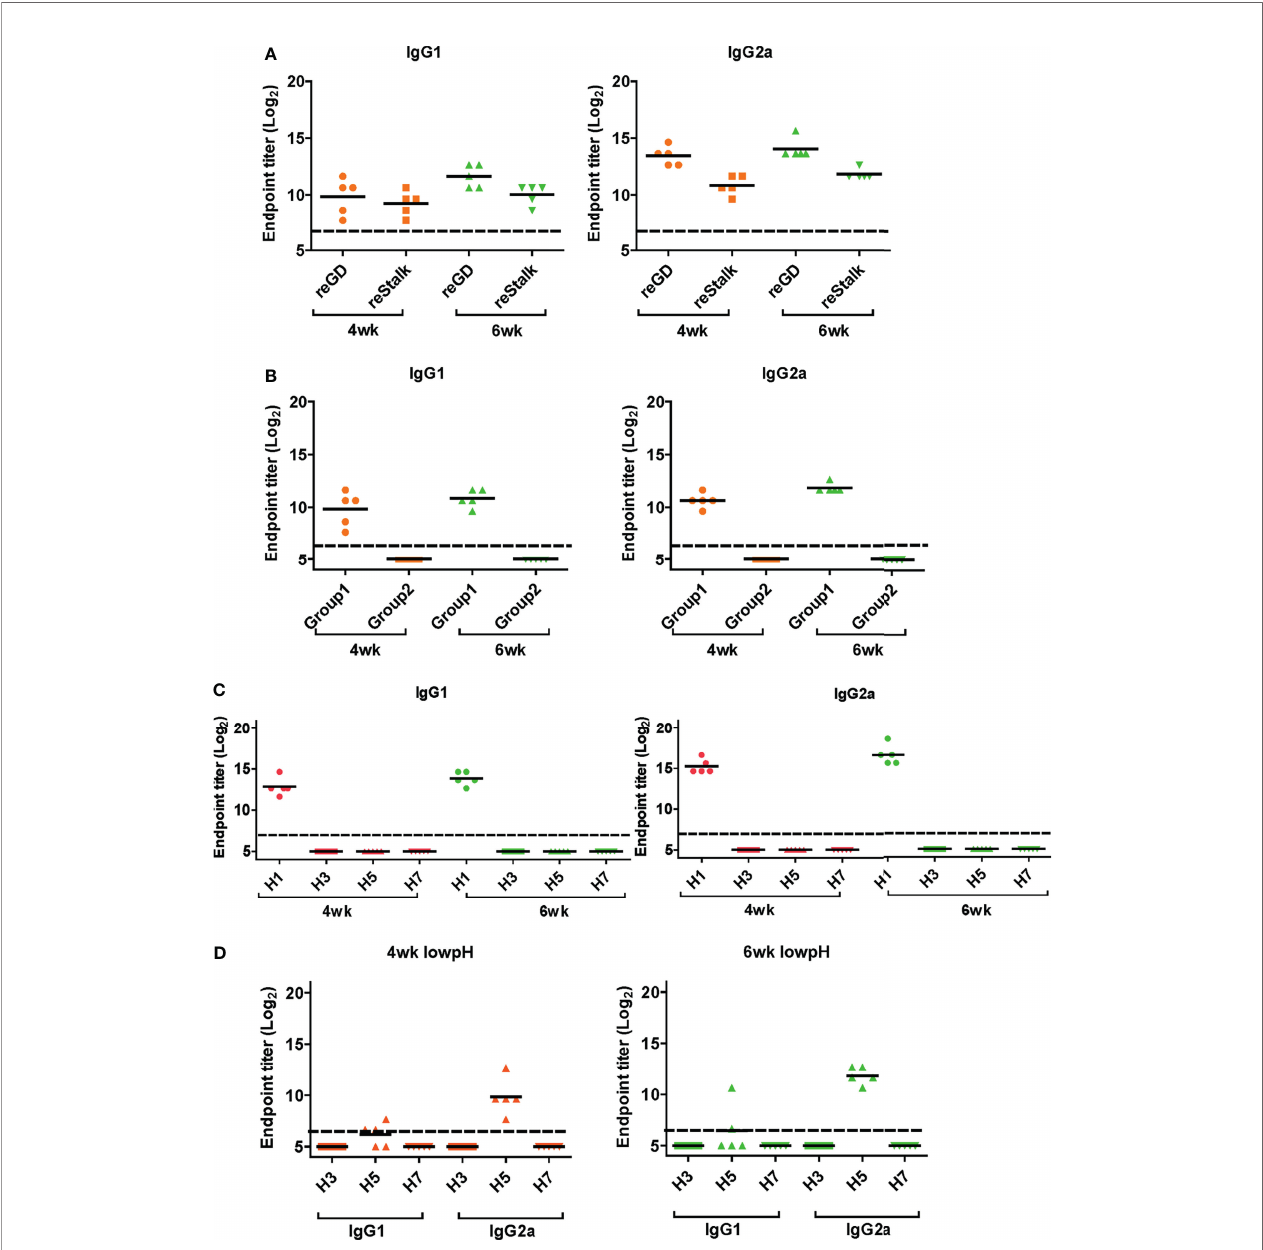
FIGURE 5 | Response of cross-protective antibodies to hemagglutinin (HA) proteins. (A – D) In fl uenza HA protein-speci fi c IgG1 and IgG2a were detected by ELISA analysis. Two-fold serially diluted mice sera collected at 4 or 6 weeks post-vaccination were bound to recombinant GD and HA stalk (A) , consensus HA stalk (B) expressed in Escherichia coli , and commercial (Sino Biological) full HA proteins (C, D) . Especially (D) HA proteins were pre-treated at low pH to expose the stalk. The graph shows the endpoint (E.P) of each cohort (N=5). E.P means the reciprocal serum dilution of the vaccinated group that yielded OD 450 greater than the mean + 2SD of the PBS-treated